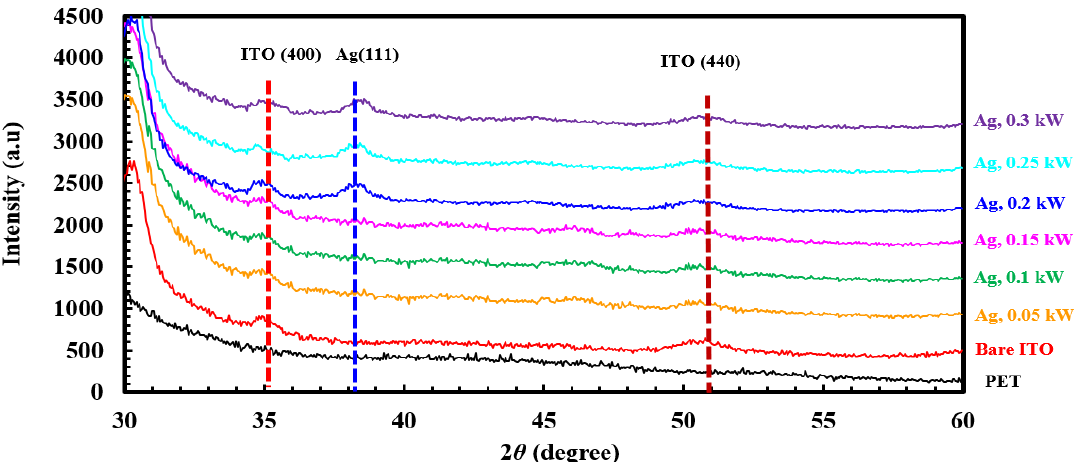
Figure 4. XRD plots obtained from the flexible ITO/nano-Ag/ITO electrodes grown on the PET substrate as a function of the Ag dc power, in the range from 0.05 to 0.3 kW.